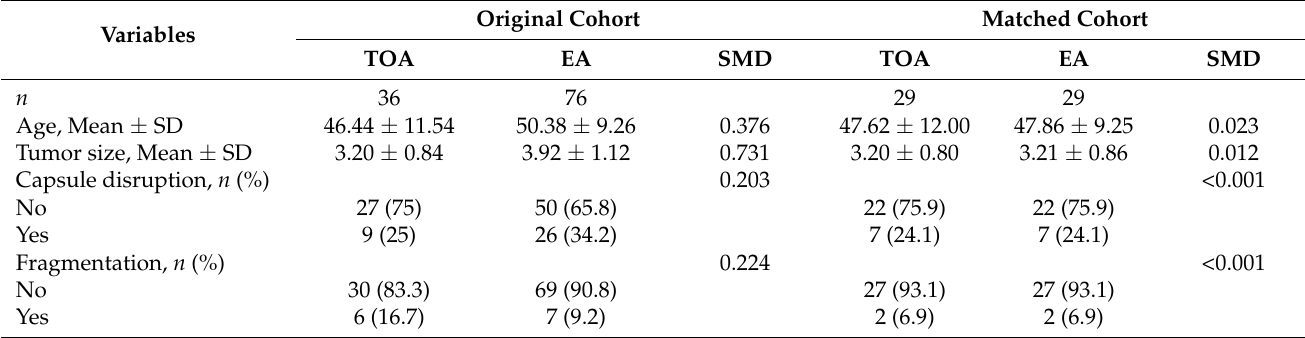
Table 1. Baseline characteristics of patients in the transoral approach and external approach groups before and after PSM. Variables